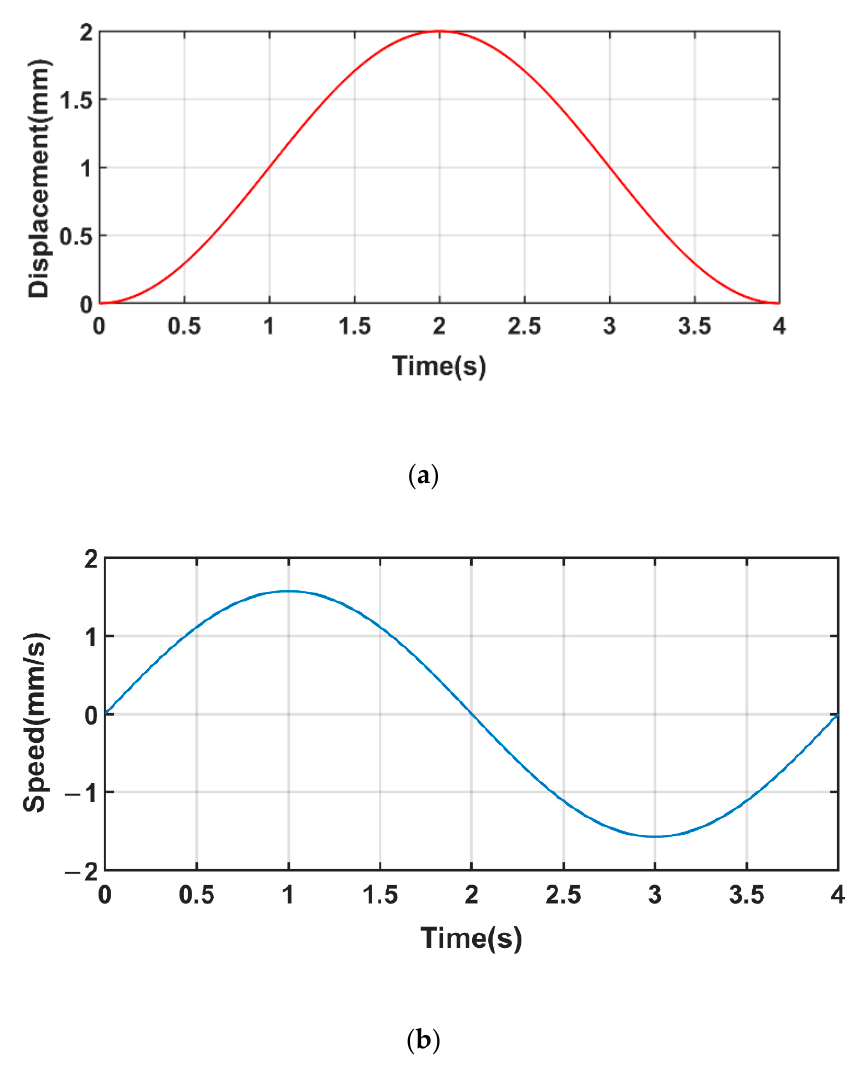
Figure 7. Curve of input signal: ( a ) desired position signal; ( b ) desired speed signal.